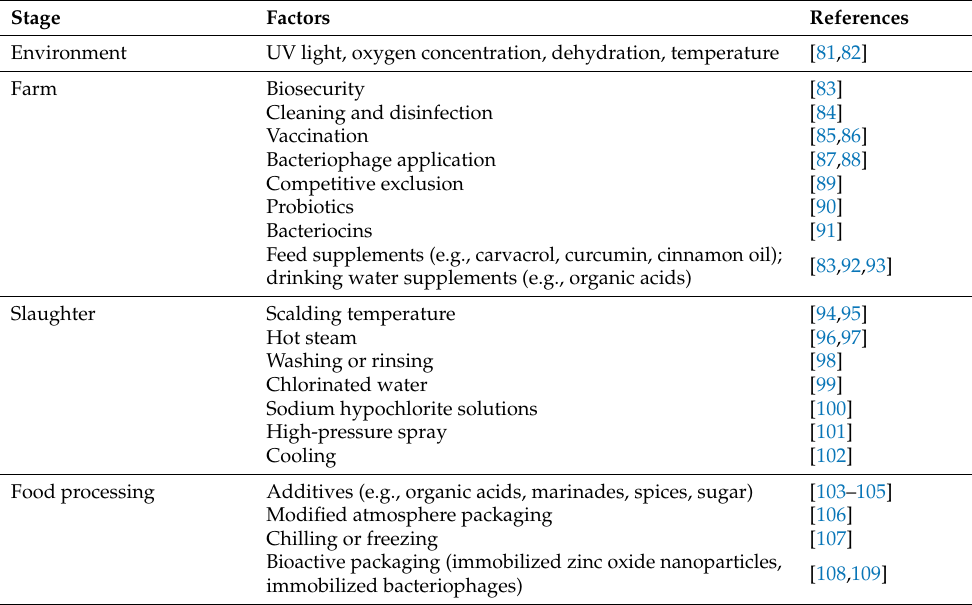
Table 1. Factors influencing survival of Campylobacter from the farm to the